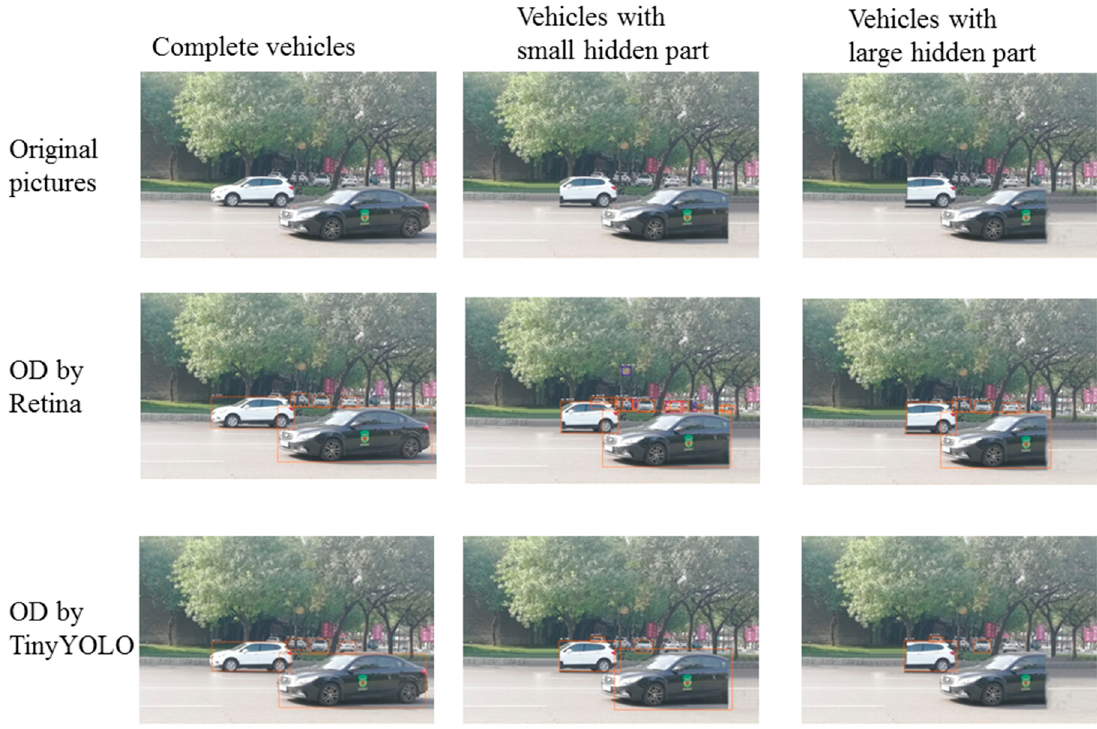
Figure 1. The photos demonstrate that the stat of the art object detection algorithms cannot “see” the hidden part of the vehicles.